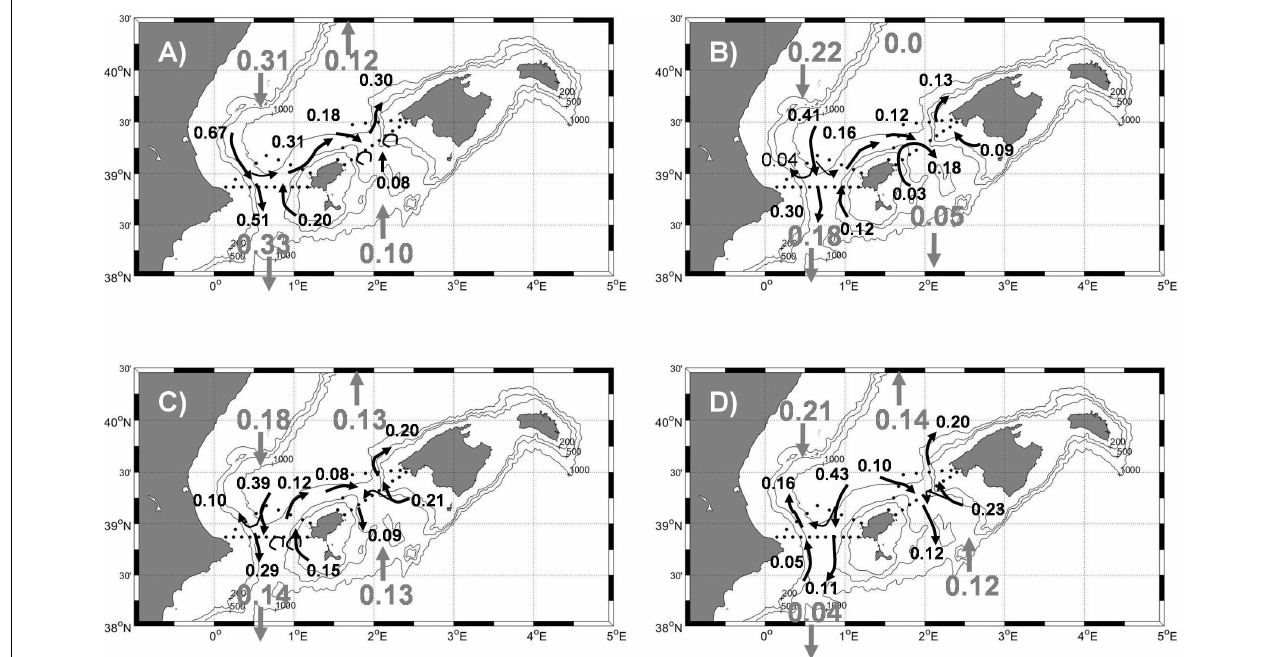
FIGURE 12 | Schematic circulation in the upper layer (AW + WIW) during winter (A) , spring (B) , summer (C) and autumn (D) . Mass transports are expressed in 10 9 kg/s, which approximately correspond to 1 Sverdrup. Net transports for the upper layer are expressed with gray numbers.